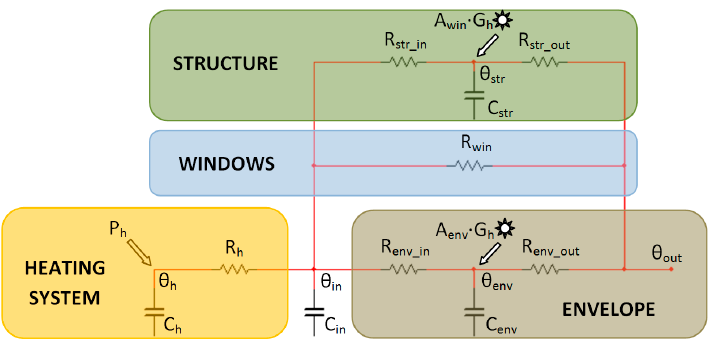
Figure 2. RC ‐ model of the dwelling. Figure 2. RC-model of the